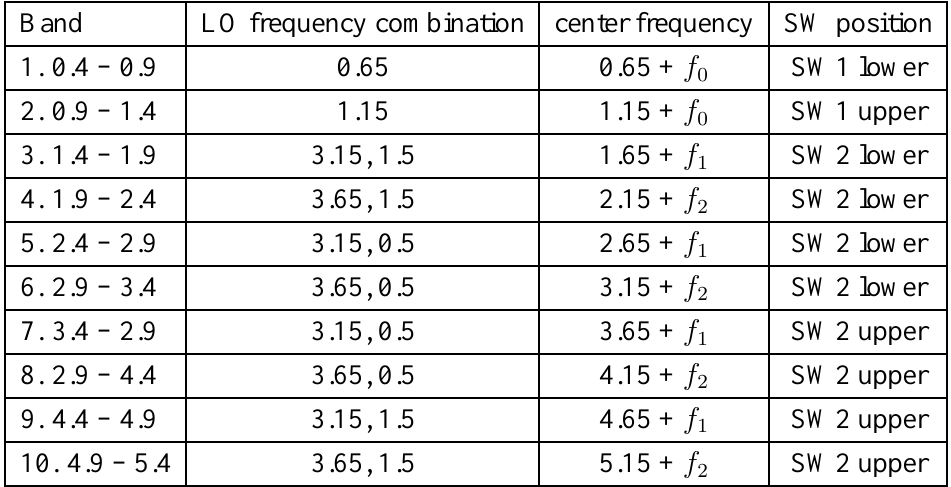
Table 2. Transmitter frequency parameters